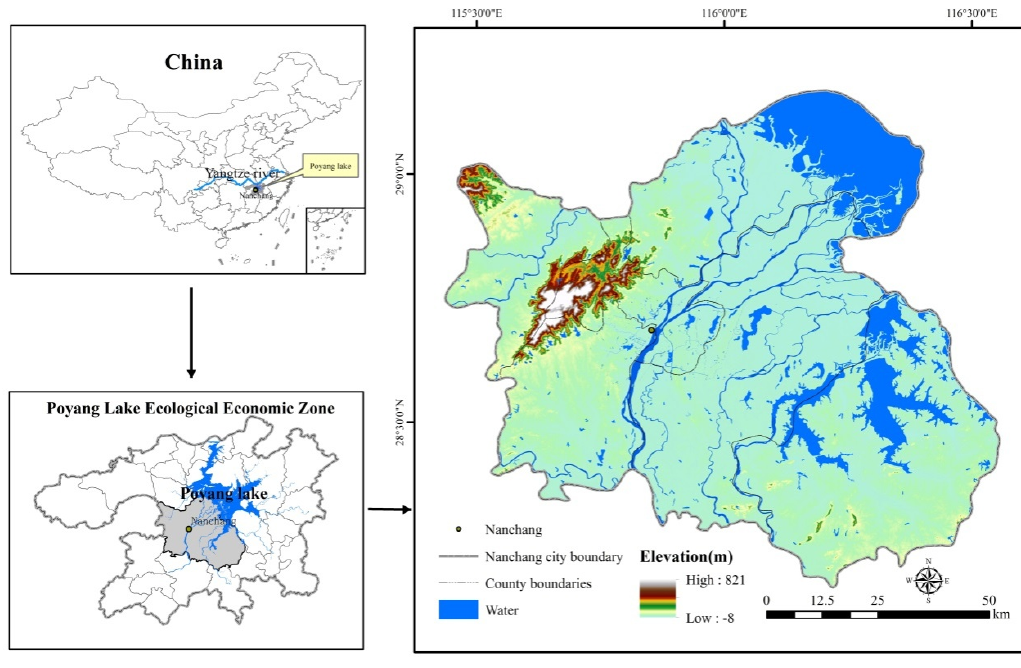
Figure 1. Location of the study extent.